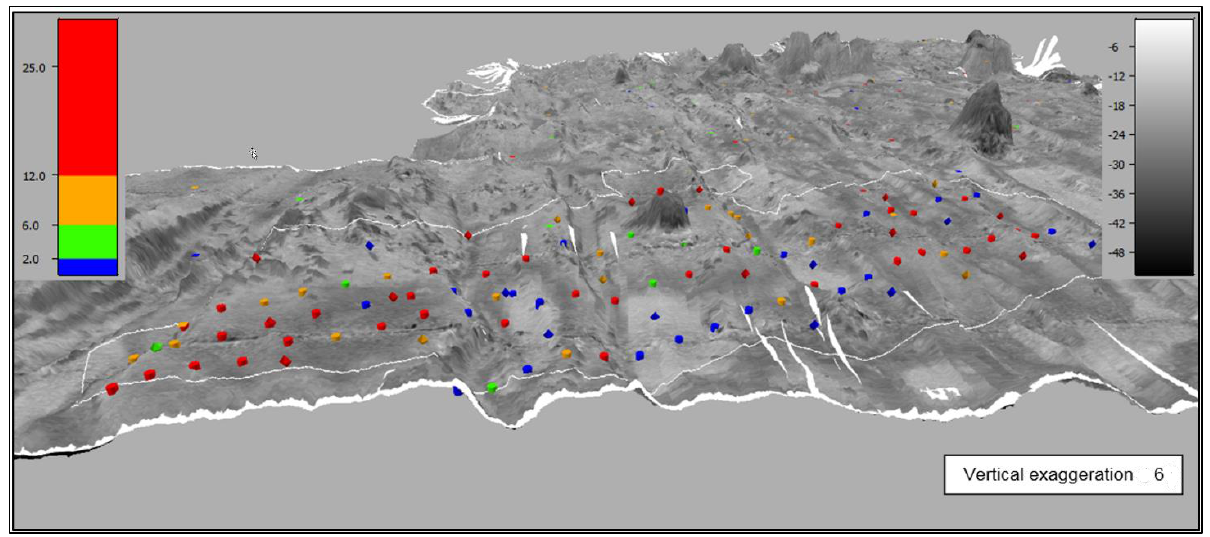
Figure 8. Nodule-rich and nodule-poor areas on a typical area of seafloor in the CCZ. The scheme shows 12-kz multibeam echosounder (MBES) backscatter based on bathymetry and sample data. For scale, the sample symbols are typically 3-km apart (refer also to Figure 9). Abundance (coloured) is given in wet kg/m 2 ; the acoustic absorption (backscatter; grey scale) is in dB. Very dark areas generally relate to exposed volcanics (no nodules to speak of and not sampled), very light areas generally relate to sediment drifts (some sampled), and intermediate grey areas are nodule-bearing sediments. Within the white outline is the area that was estimated to an indicated and measured level of confidence, while outside, it was estimated to an inferred level.